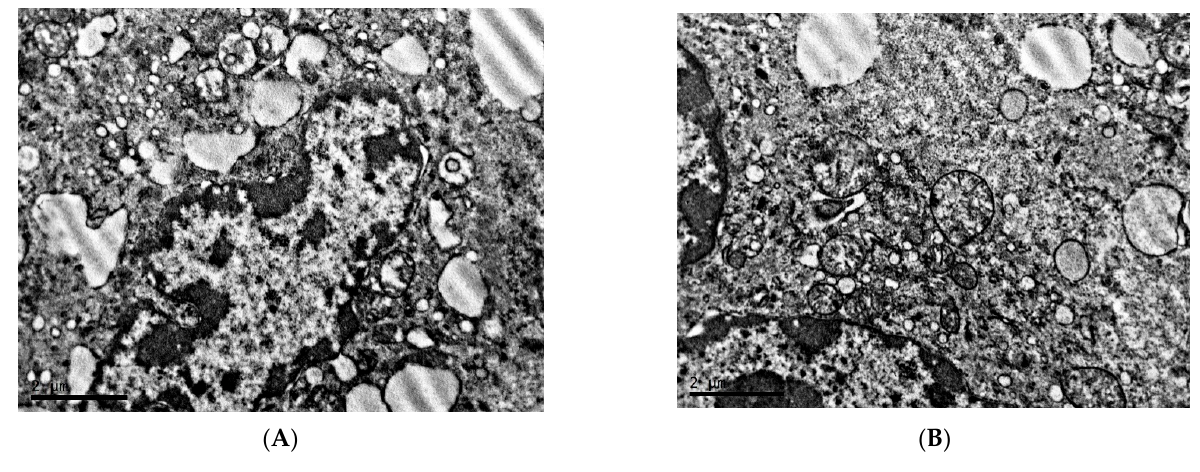
Figure 2. Organelles of cells of transplantable malignant melanoma B16 under the influence of fixed light regime. TEM, ( A )— × 10,000, ( B )— ×